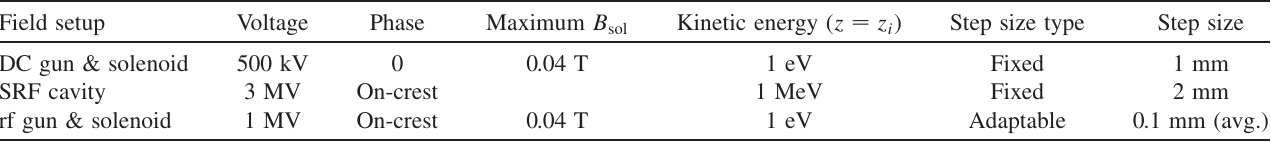
TABLE I. Simulation parameters.